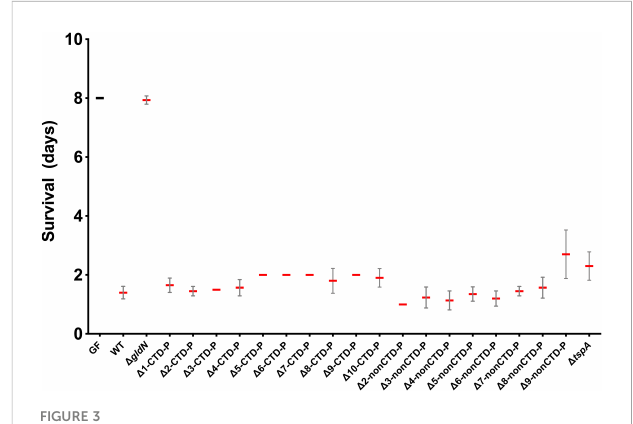
FIGURE 3 Virulence of F. columnare wild type and peptidase mutants toward germ-free (GF) zebra fi sh larvae. Fish were infected at 6 days post- fertilization by immersion at 10 4 colony-forming-units (CFU)/mL. Zero days post-infection (dpi) corresponds to the day of infection. Mean survival is represented by a thick horizontal bar with error bars for standard deviation. “ GF ” (germ-free) indicates noninfected larvae. Length of survival is shown for larvae exposed to the strains indicated. The number of days of survival for fi sh challenged with any of the peptidase gene deletion mutant strains were not signi fi cantly different from those of the wild type. The survival for fi sh challenged with the D gldN mutant was not signi fi cantly different from the noninfected GF control.